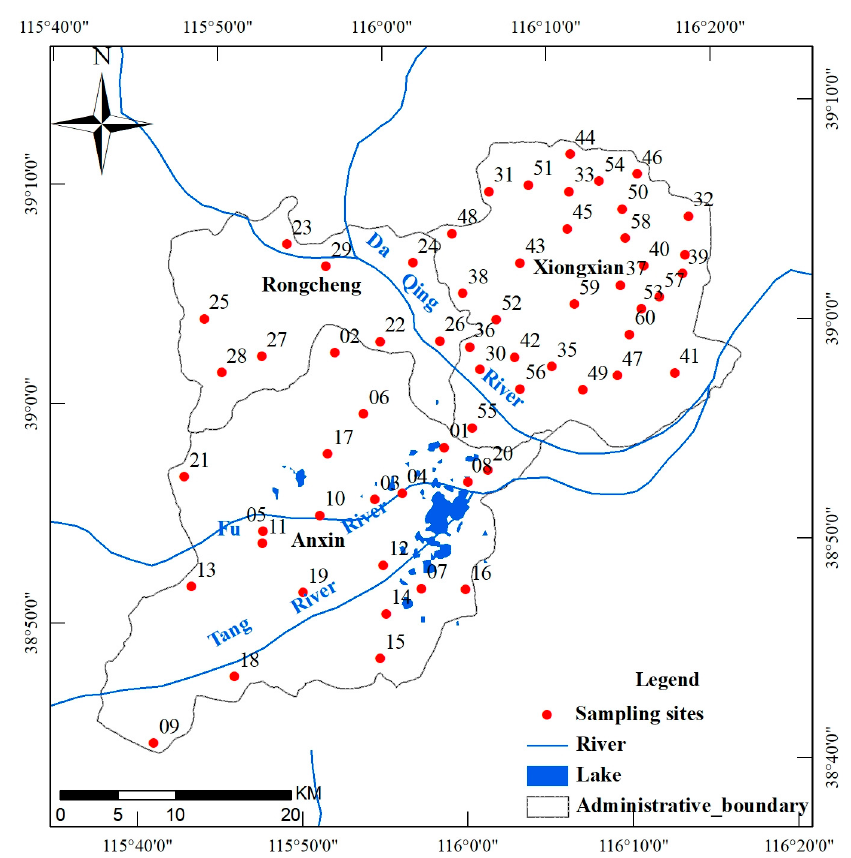
Figure 2. Distribution of sampling sites in the study area.